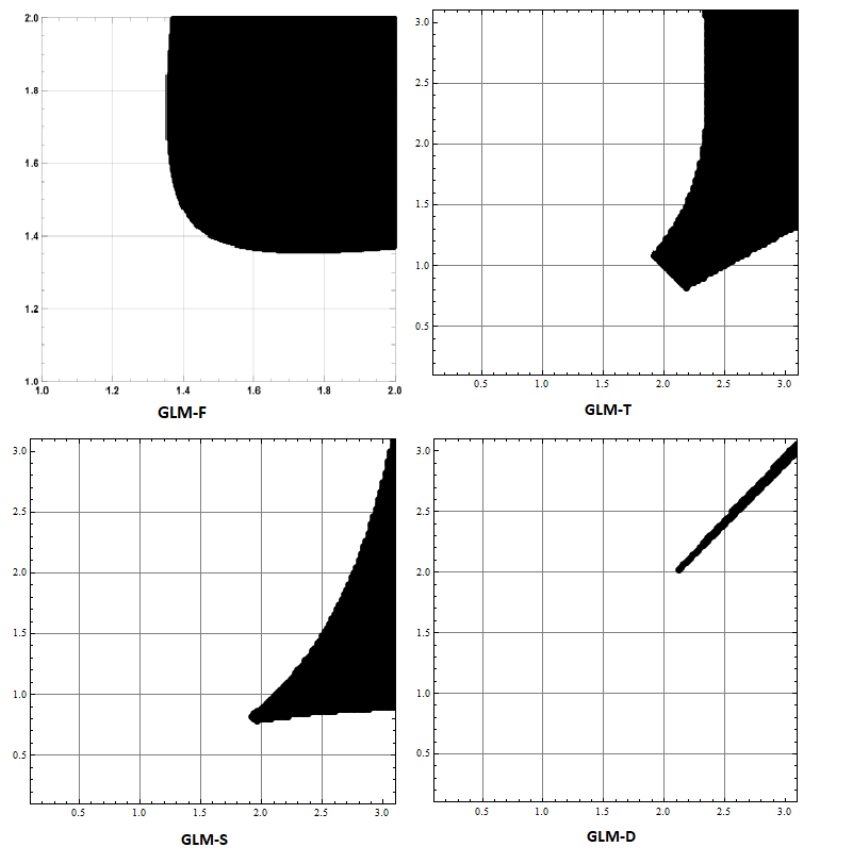
Figure 1. Regions of A-stability in the ( c 1 , c 2 )